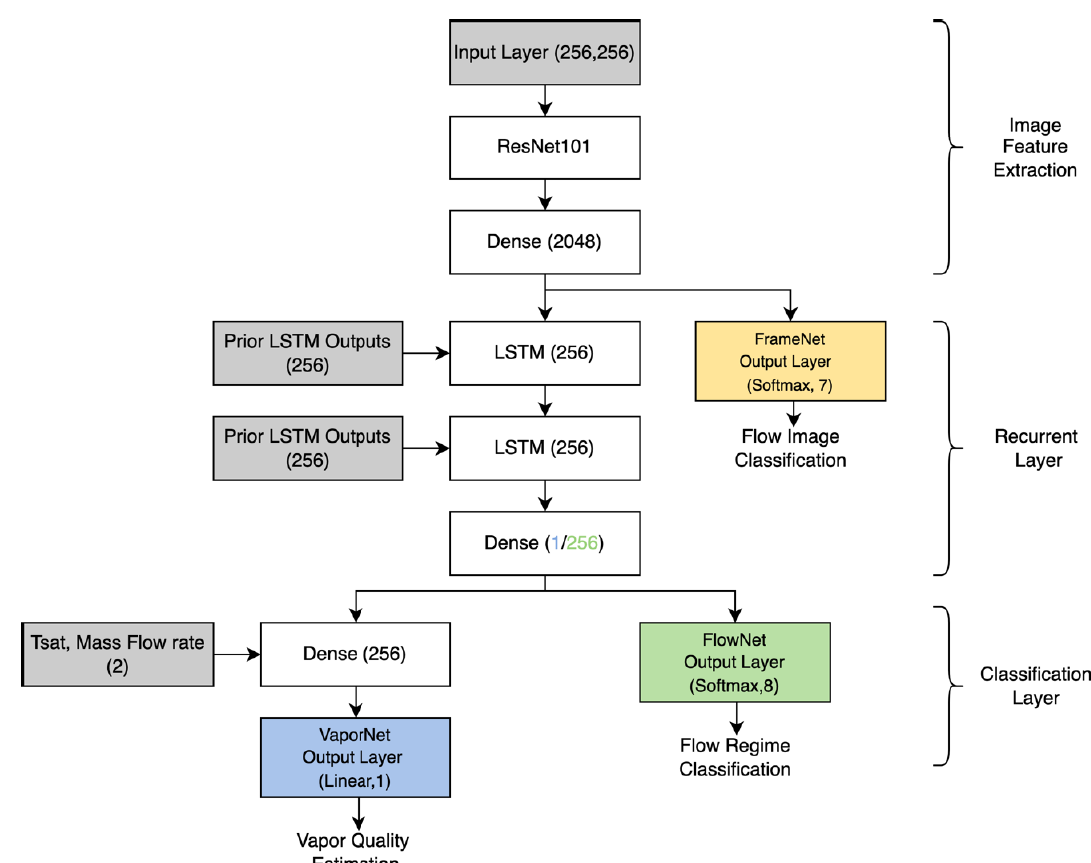
Figure 3. High-level network architecture, with paths for FrameNet (yellow), VaporNet (blue), and FlowNet (green). The number of neurons in each component is shown in brackets.